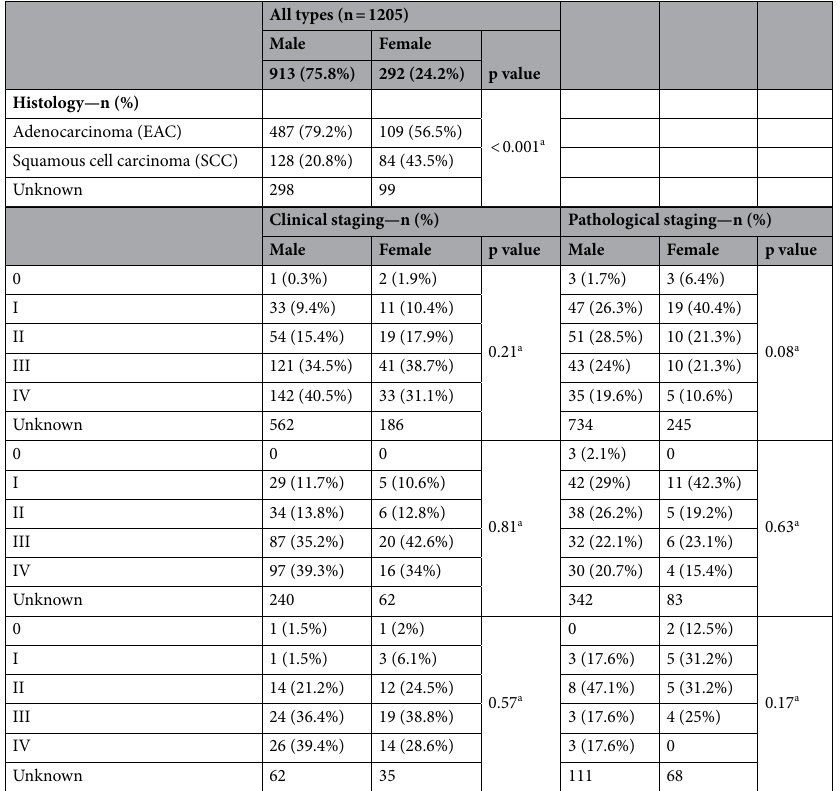
Table 2. Cancer characteristics by sex for all types of esophageal cancer combined, esophageal adenocarcinoma (EAC) and squamous cell carcinoma (SCC), UH Seidman Cancer Center Database (2005– 2020). a Chi-square